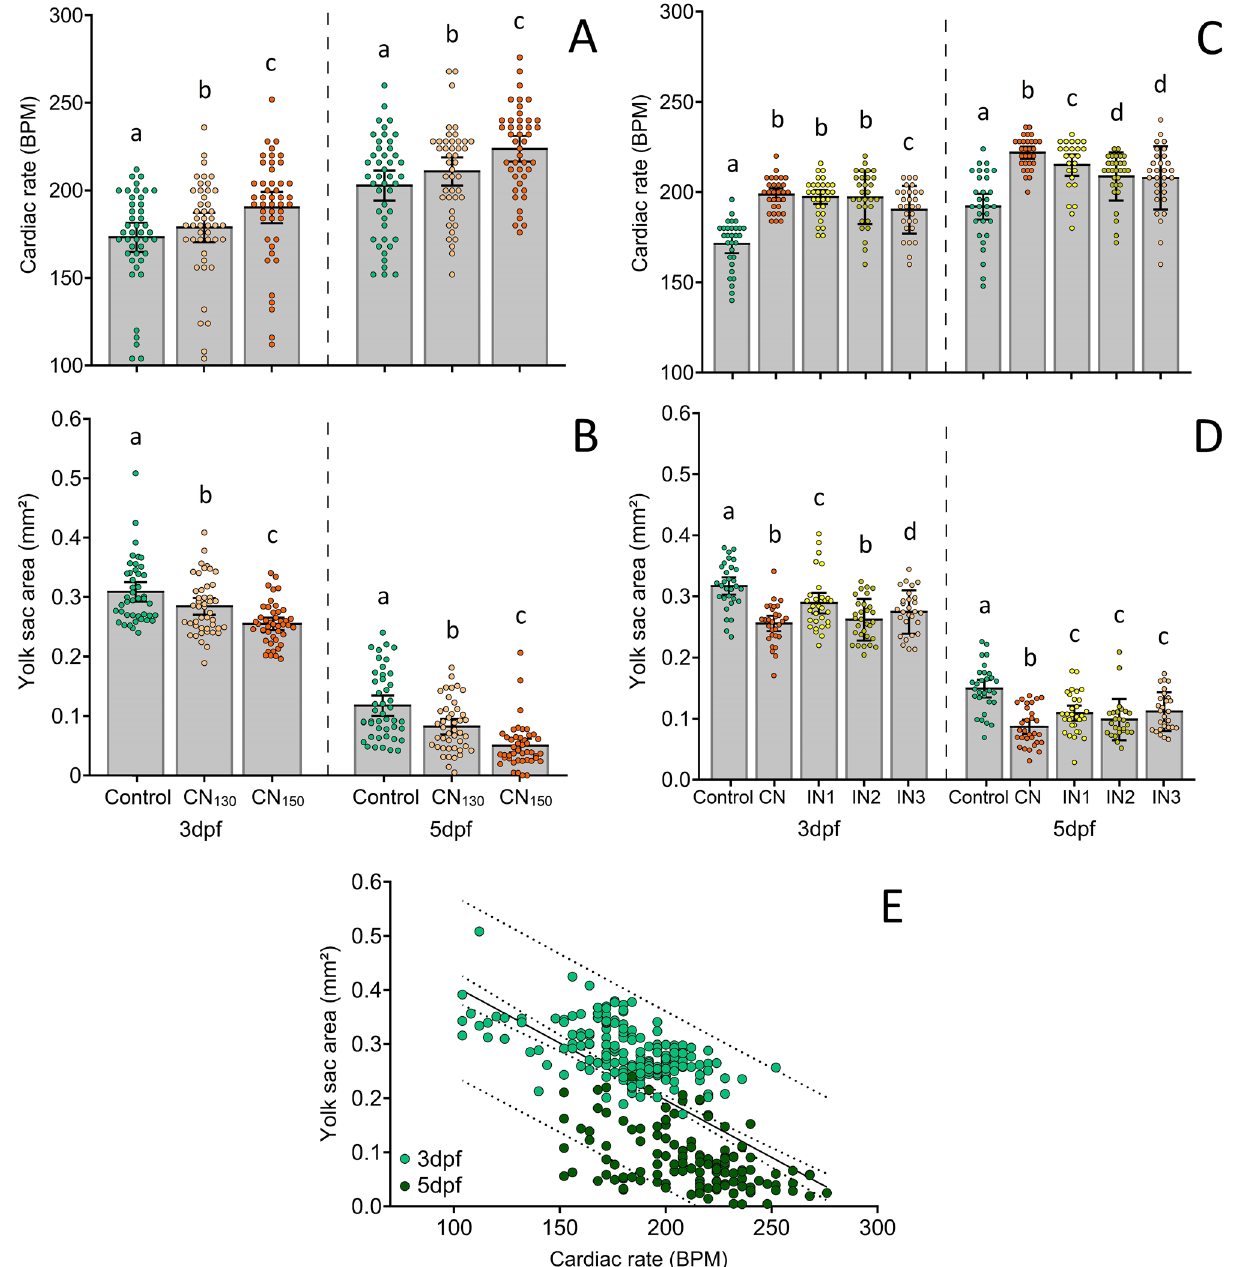
Figure 2. Comparison of mean cardiac rate and yolk sac area of larval zebrafish with 3 and 5 dpf (days post fertilization) exposed to different noise amplitudes ( A and B ) and temporal patterns at 150 dB re 1 μPa ( C and D ). Increasing noise amplitudes induced heightened cardiac rate at 3 dpf (F (2, 134) = 4.20, p = 0.004) and 5 dpf (F (2, 133) = 7.17, p = 0.002), as well as a decrease in yolk sac (3 dpf—F (2, 136) = 11.96, p < 0.001; 5 dpf—F (2, 134) = 16.59, p < 0.001). Cardiac rate was further affected by noise temporal variation at 3 dpf (F (4, 146) = 25.36, p < 0.001) and 5 dpf (F (4, 143) = 15.50, p < 0.001), as well as the yolk sac 3 dpf (F (4, 145) = 13.79, p < 0.001) and 5 dpf (F (4, 143) = 12.19, p < 0.001). Error bars represent 95% confidence intervals. Different letters indicate statistically significant differences between specific groups based on post hoc tests. ( E ) Correlation between cardiac rate and yolk sac size (R = − 0.61, N = 370, p < 0.001) from both 3 and 5 dpf. Solid line—best-fitted line; inner dashed lines— standard error of the mean; outer dashed lines—95% confidence